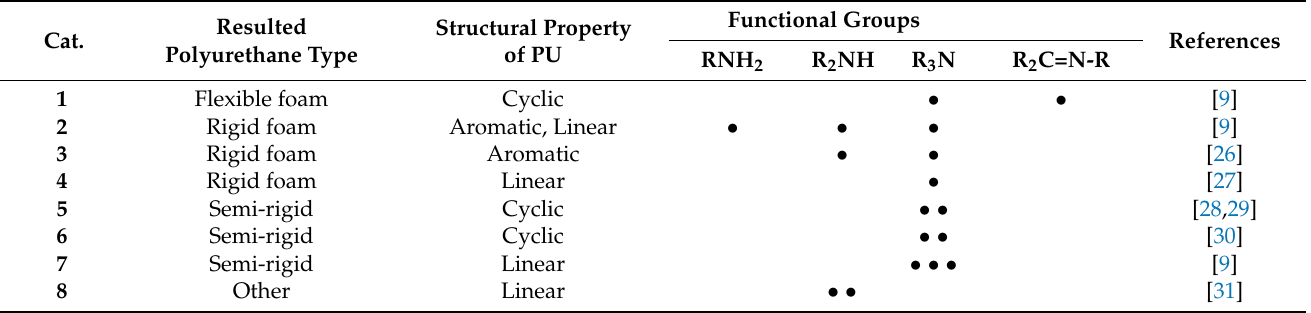
Table 2. Structural features of the studied catalysts and their applications. Cat.—catalyst, RNH 2